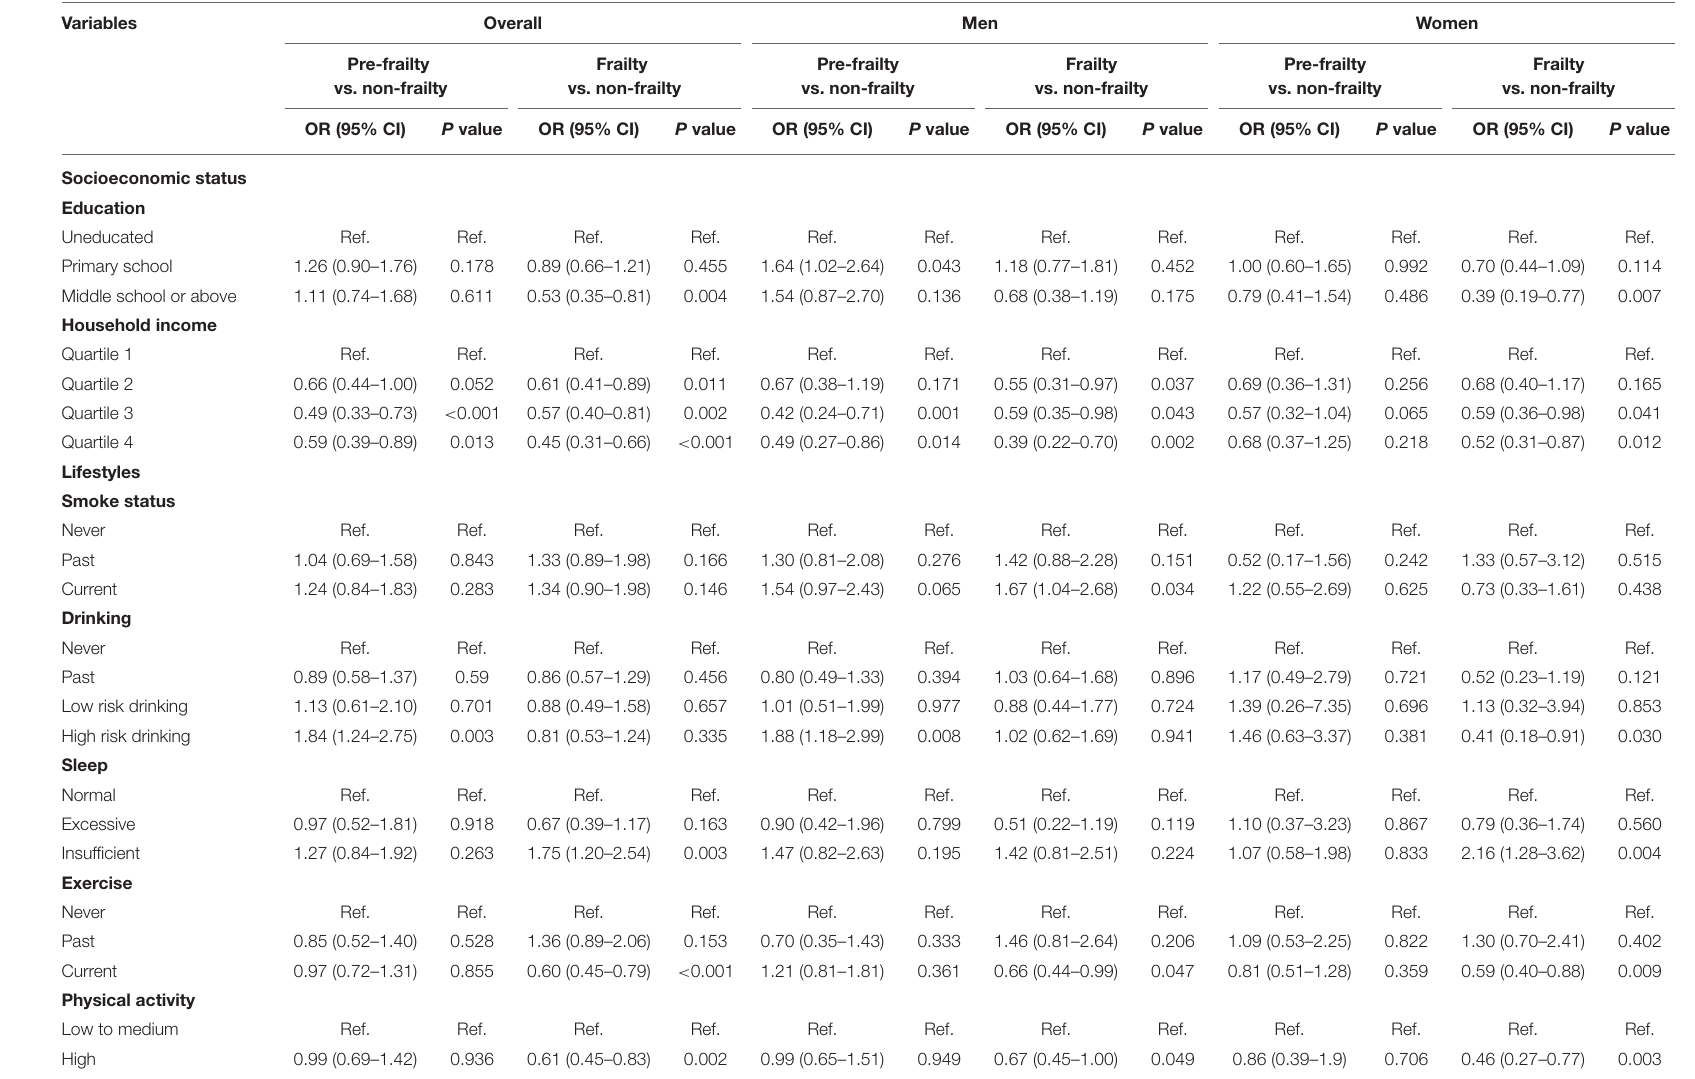
TABLE 3 | Factors associated with pre-frailty, frailty, and sex